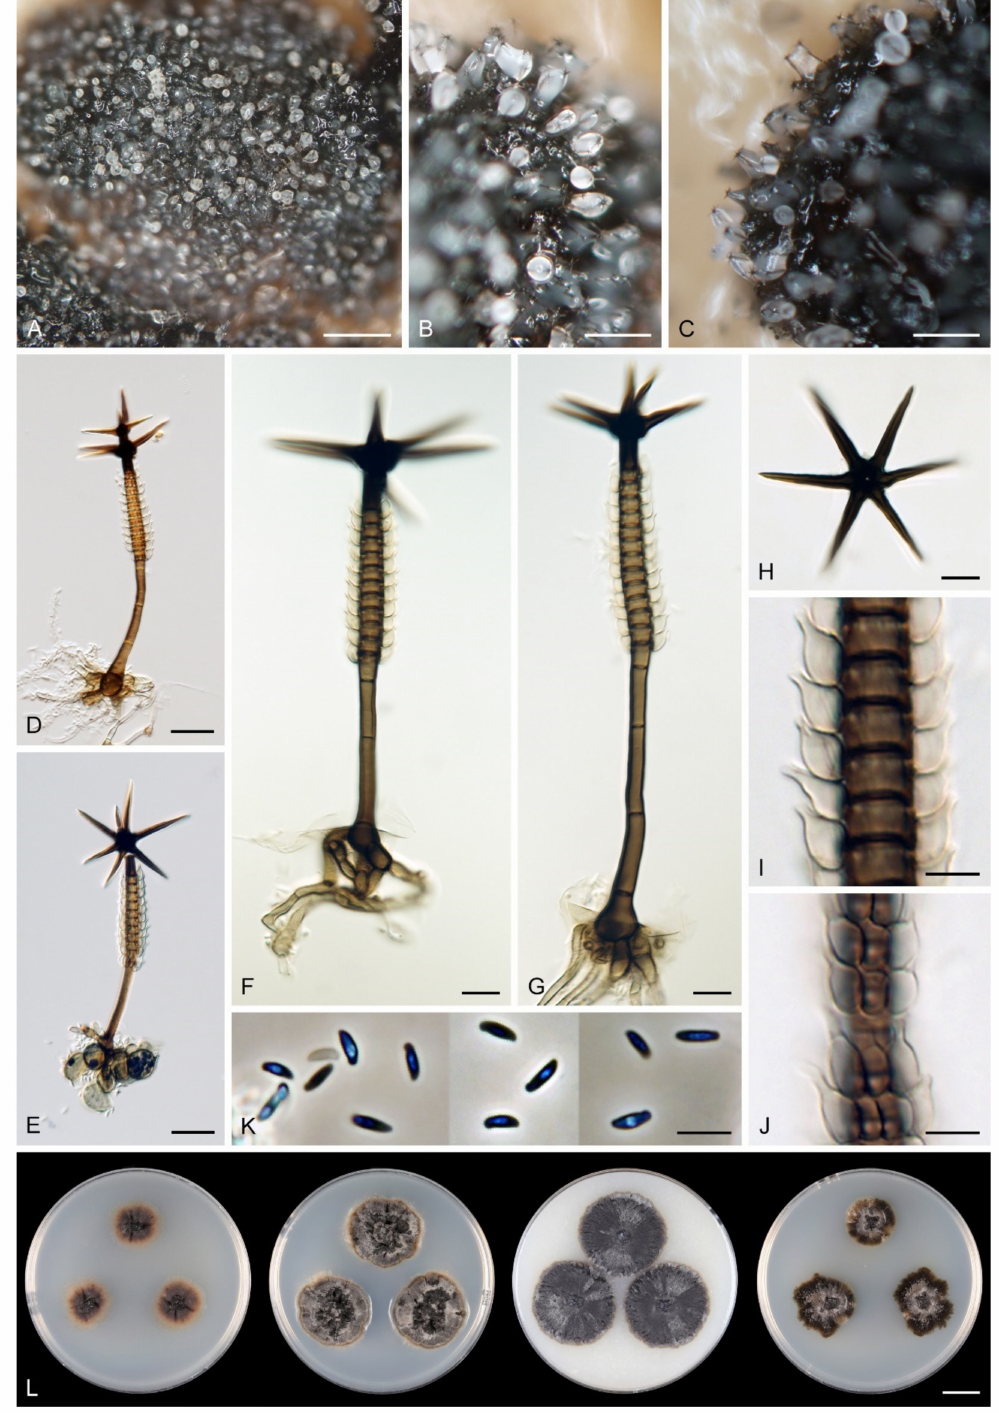
Figure 20. Stephanophorella stellata (CBS 101301 ex-type). ( A – C ) Colonies with conidiophores, in detail. ( D – G ) Conidiophores. ( H ) Branches arranged in a stellate fashion. ( I , J ) Conidiogenous cells. ( K ) Conidia. ( L ) Colonies on CMD, MLA, OA and PCA after 4 weeks (from left to right). Images: ( A – K ) on CMA after 6 weeks. Bars: ( A ) = 500 µ m; ( B , C ) = 200 µ m; ( D , E ) = 20 µ m; ( F – H ) = 10 µ m; ( I – K ) = 5 µ m; ( L ) = 1